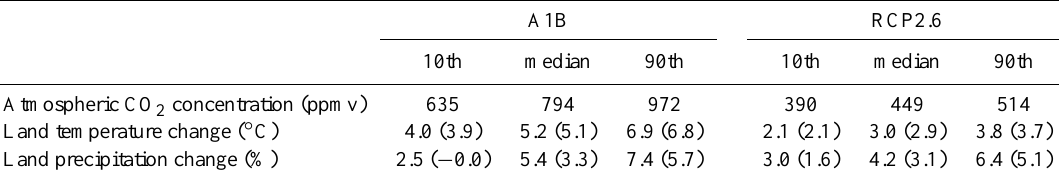
Table 1. The end-of-century range of atmospheric CO 2 concentration (extract from Booth et al., 2012, 2013), temperature and precipitation given by the ESE simulations for the SRES A1B and RCP2.6. CO 2 is the 2099 value. Temperature and precipitation are based on the end-of- century 10yr average (2070–2099) relative to the 1961–1990 average, over all global land points. Values in parentheses exclude cold regions as described in the